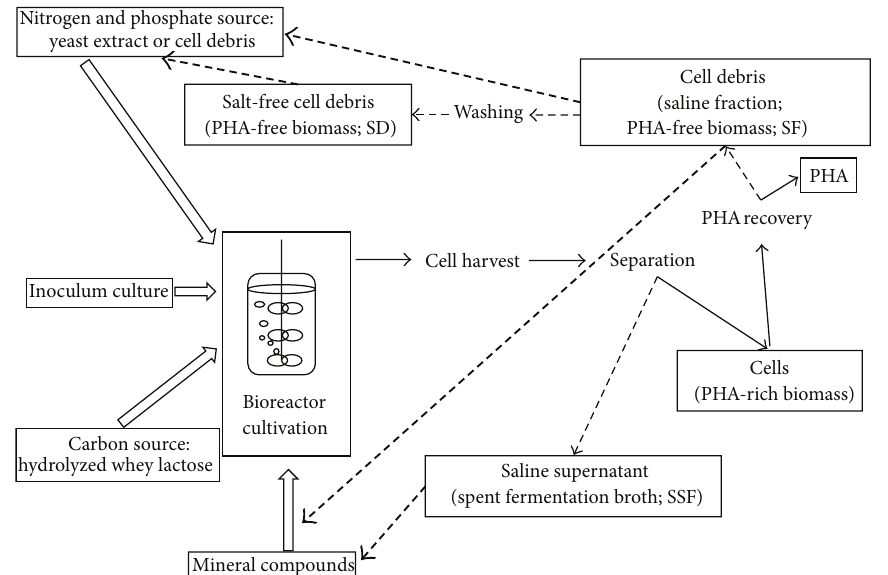
Figure2:SchemeofaclosedrecyclingsystemforreutilizationofwastestreamsfromfermentativePHAproductionprocessby H.mediterranei based on the feedstock whey. The saline supernatant SSF should be used to partly replace mineral compounds in subsequent fermentation processes, whereas salty (SF) or salt-free (SD) cell debris should be used as nitrogen and phosphate source in order to reduce the required amount of yeast